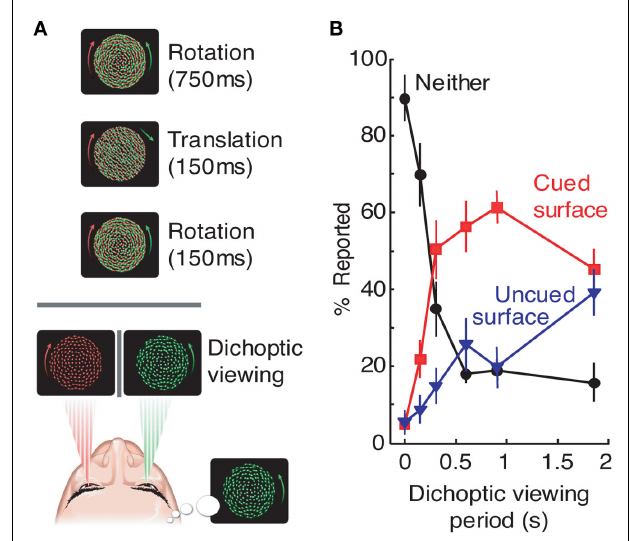
FIGURE 3 | Exogenous attention biases initial dominance in binocular rivalry. In a study by Mitchell et al. (2004), rivalry was initiated between conflicting rotating surfaces, one of which was cued during preceding binocular presentation by a brief translation period (A) . After rivalry was initiated, observers reported which of the two surfaces was dominant at the end of variable dichoptic viewing periods (B) . After 150ms of dichoptic viewing, in most cases observers did not perceive exclusive dominance of either surface, consistent with previous reports (Wolfe, 1983). However, for viewing periods between 300 and ∼ 1500ms, the cued surface was the predominant percept, indicating a strong effect of attention on the initial dominance during rivalry. Adopted from Mitchell et al. (2004). Adapted by permission from Macmillan Publishers Ltd.: Nature, copyright